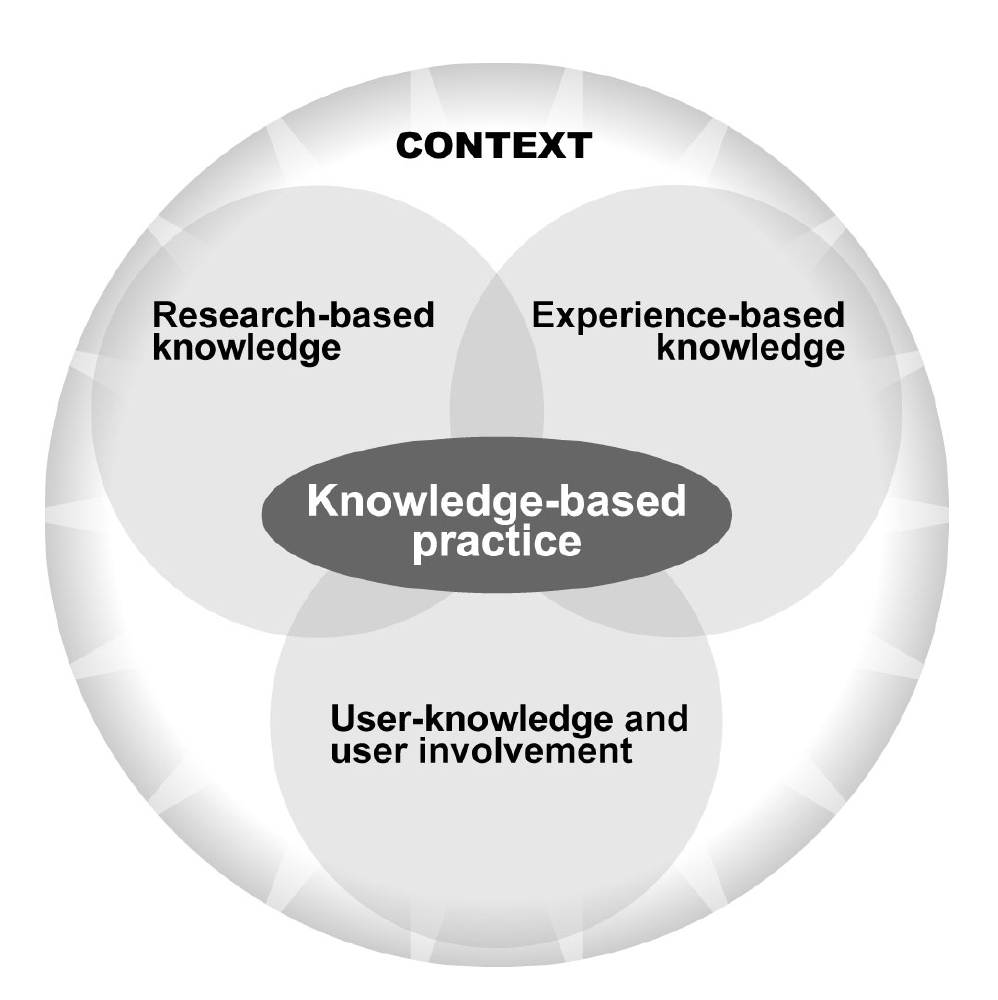
Figure 1 : The KBP/EBP model: The model of Knowledge-based practice/Evidence-based practice as presented by Helsebiblioteket. no. (authors